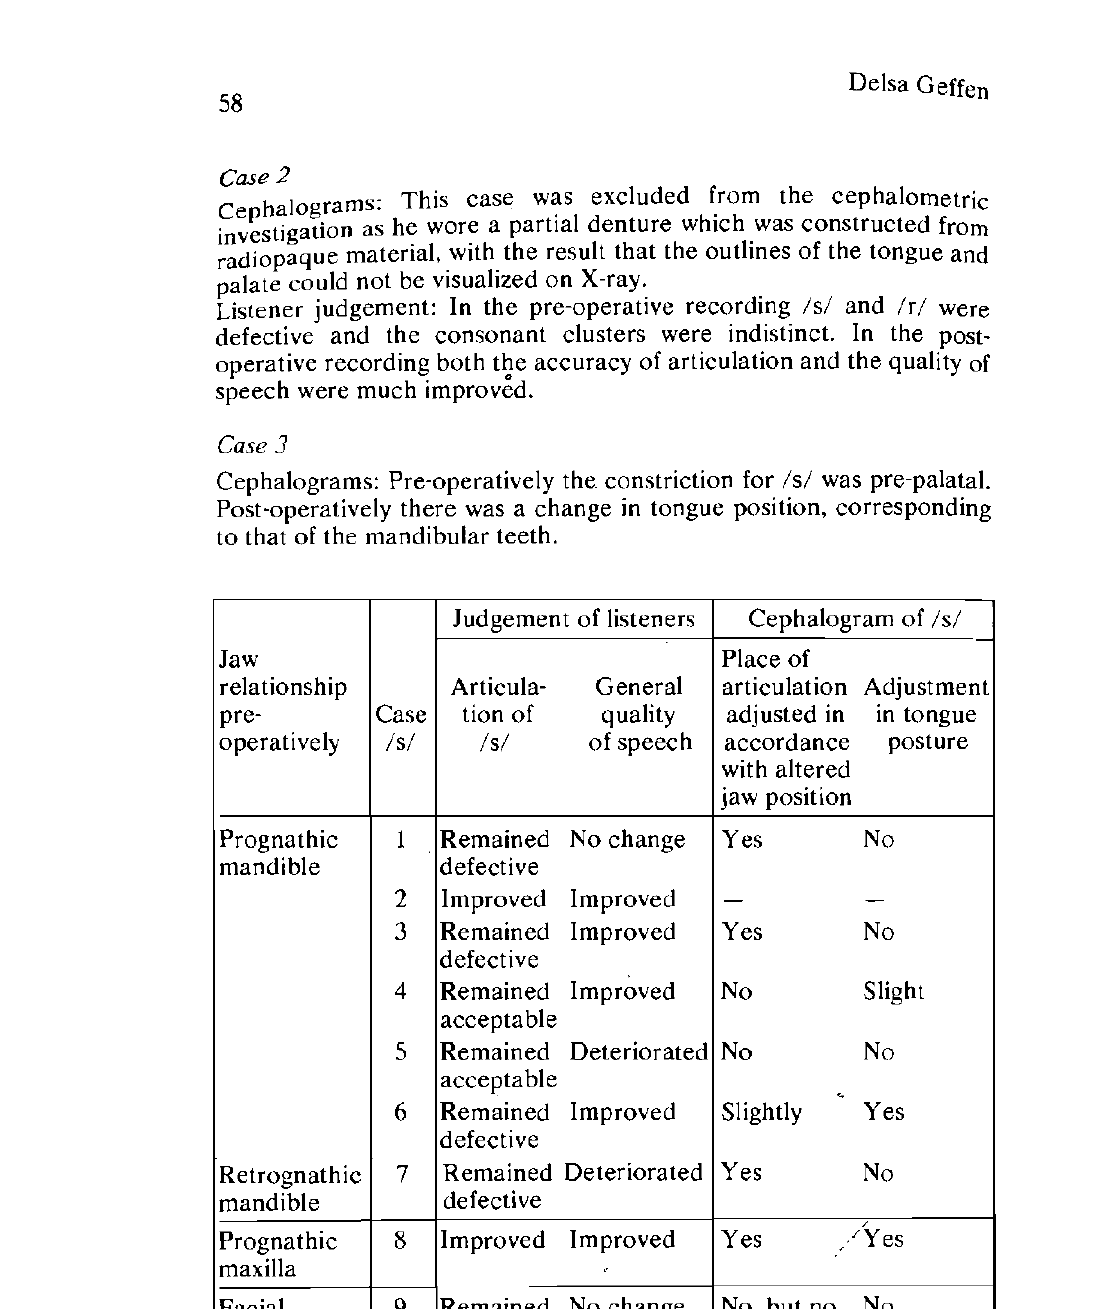
Listener judgement and cephalograms for pre- and post- operative production of